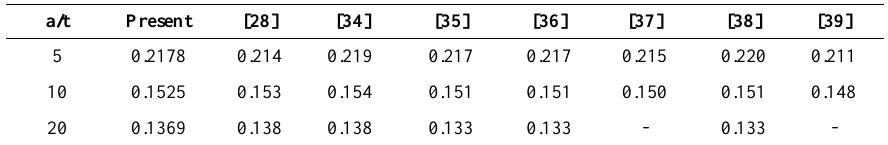
Table 2. Comparative deflection analysis for square plate at varying span-thickness ratio (β = a/t) between present study and past studies